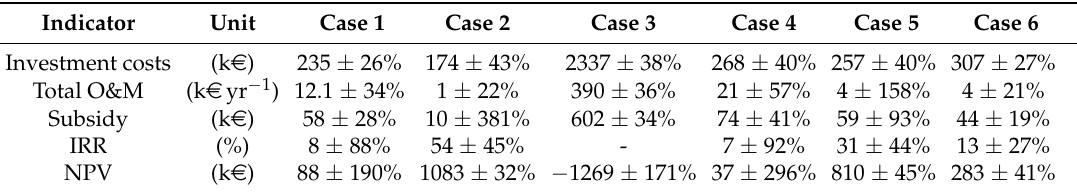
Table 7. Economic results for the case studies with uncertainty (standard deviation of the MC simulations) in